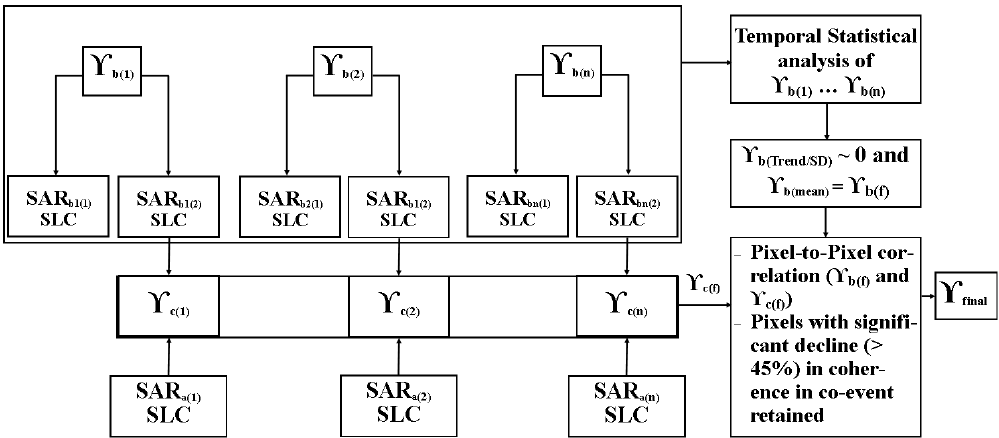
Figure 2. Flowchart portraying the procedures to map inundated areas using coherence change detection (CCD). SAR bn(n) and SAR a(n) refer to the pre- and post-disaster SAR images, respectively; ϒ b(n) and ϒ c(n) signify pre-disaster and co-event coherence products, respectively; ϒ b(f) and ϒ c(f) refer to the (final) products of the pre-event and co-event pairs, respectively; ϒ final denotes the resulting final coherence change product. SD denotes the standard deviation. Remote Sens. 2020 , 12 , x FOR PEER REVIEW